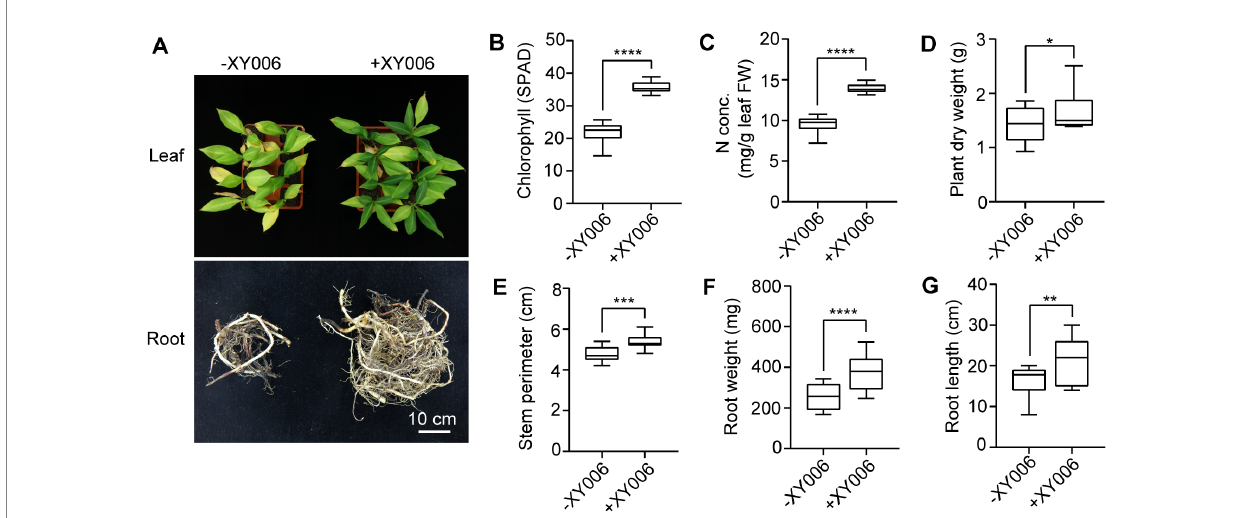
FIGURE 7 Plant growth promoting effect of banana seedlings with and without strain XY006 inoculation. (A) Leaf and root phenotypes of banana seedlings treated with strain XY006 after a two-month growing period in pots. Bar = 10 cm. (B) Leaf chlorophyll content (SPAD value). (C) Leaf nitrogen content.